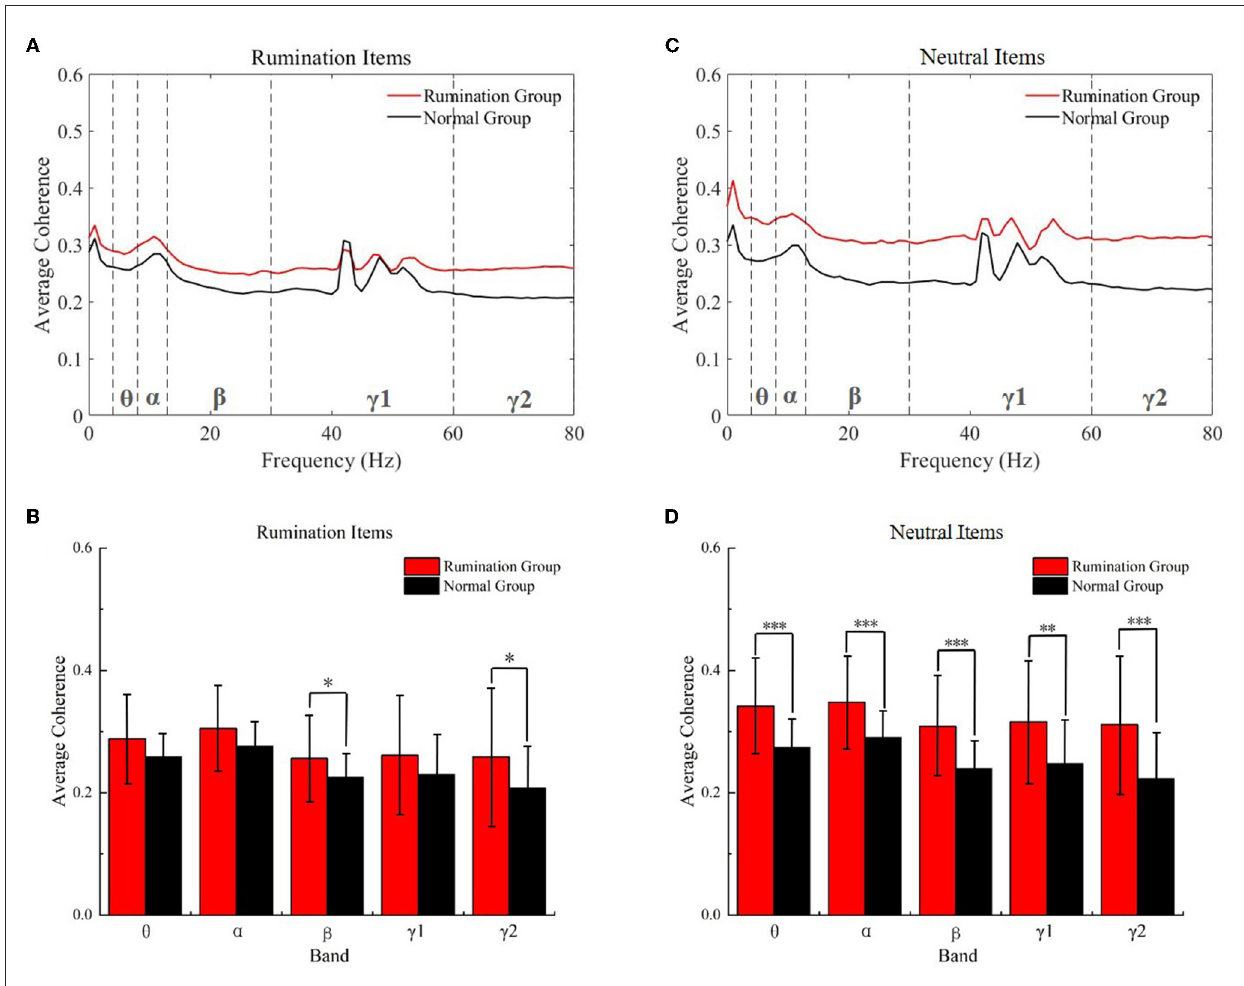
FIGURE4 Within-item coherence analysis of the two groups while they engaged with the rumination items and neutral items. (A) Average coherence of all frequency bands in the rumination items. (B) Average coherence of the five frequency bands in the rumination items. (C) Average coherence of all frequency bands in the neutral items. (D) Average coherence of the five frequency bands in the neutral items. * p < 0.01, ** p < 0.001, *** p < 0.001. Red, rumination items; black, neutral items; Normal Groups means control